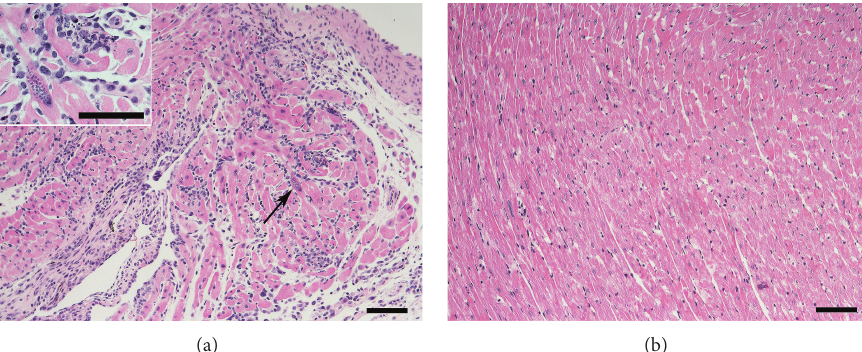
Figure 2: Parasite persistence is not the necessary outcome of heart infection by T. cruzi parasites. C57BL/6 mice were infected with 10 3 T. cruzi blood trypomastigotes of the Y strain. At days 18 (a) and 180 (b) postinfection, mice were sacrificed, and the heart tissue was formalin- fixed, included in paraffin, and stained with hematoxylin/eosin. Arrow in the figure shows an amastigote nest, which is magnified at the insert. Bars in figures correspond to 200 𝜇 m and to 100 𝜇 m at the